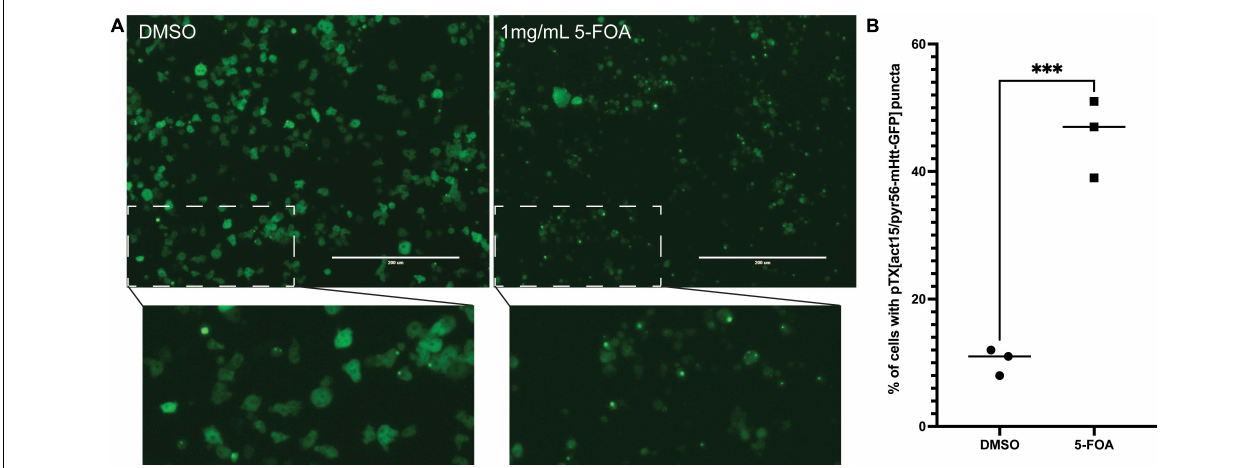
FIGURE 4 | Selection of NTG mutagenized cells with 5-FOA enriches for protein aggregation mutants. (A) Mutagenized cells treated with 5-FOA are enriched for punctate GFP. pyr56- KO cells expressing Pyr56 mHtt Q103 , GFP were treated with NTG and allowed to recover for 24 h following mutagenesis. After recovery, cells were treated with either DMSO control (left) or 1 mg/ml 5-FOA (right). Five days after 5-FOA addition, there is clear enrichment for cells containing GFP puncta in the 5-FOA treated cells when compared to the DMSO control which contains a majority of cells with diffuse GFP. This indicates enrichment of polyQ aggregation